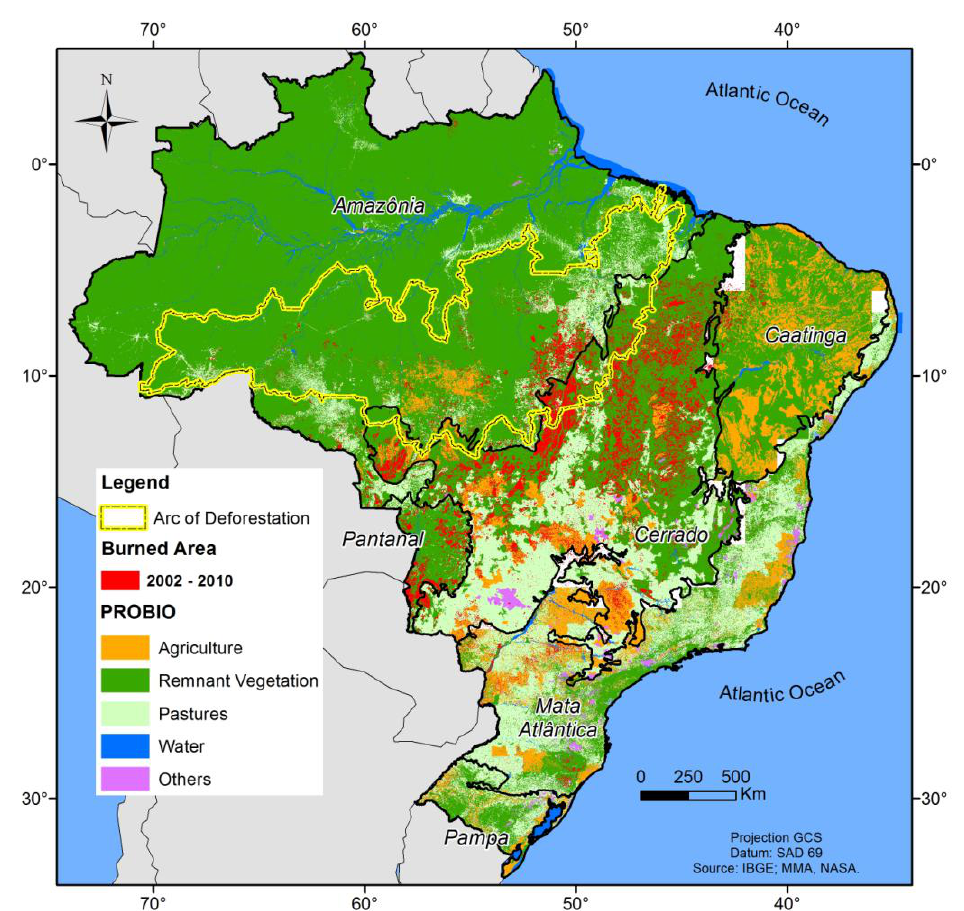
Figure 1. Spatial distribution of the total burned area (2002–2010) within the six Brazilian biomes, relative to the major land cover and land use classes (PROBIO) (Arc of deforestation limits provided by the Brazilian Environmental Agency